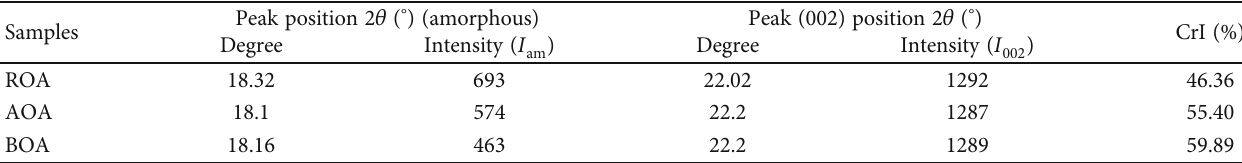
Table 3: Crystallinity index (CrI) of Oxytenanthera abyssinica at di ff erent treatment stages.